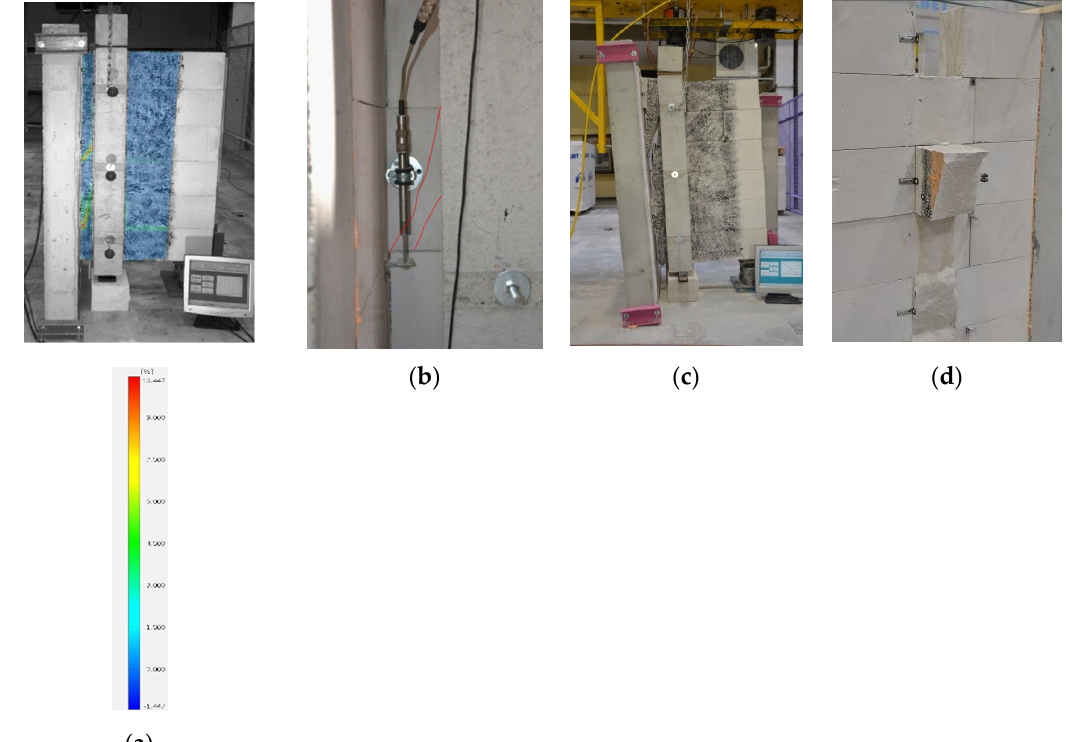
Figure 4. Destruction of models of series P ( a ) a first crack on the reference model P_2, ( b ) a first crack on the reference model P_6, ( c ) joint after failure P_5, ( d ) joint after failure P_3.